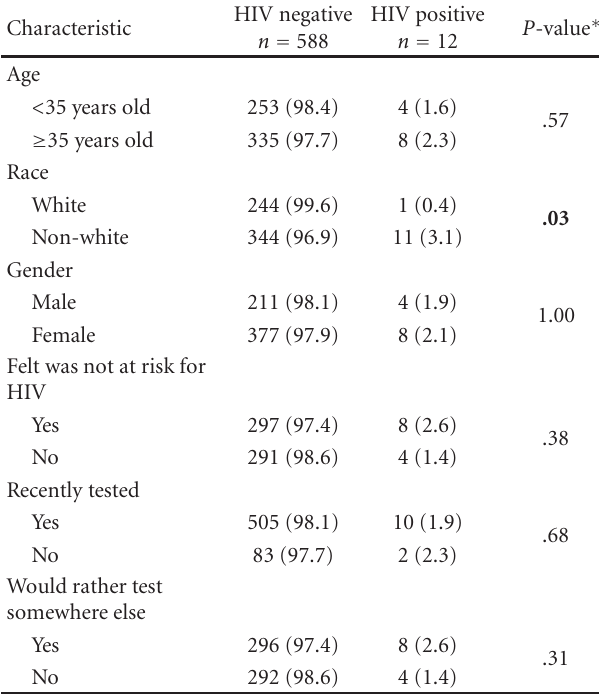
Table 3: HIV seropositivity among decliners by age, race, gender, and main reasons for declining ( n =